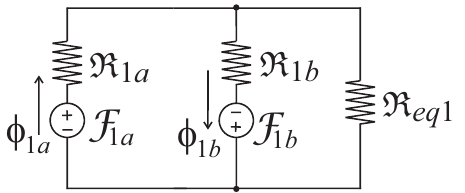
Figure 10. Equivalent circuit used for derivation of the